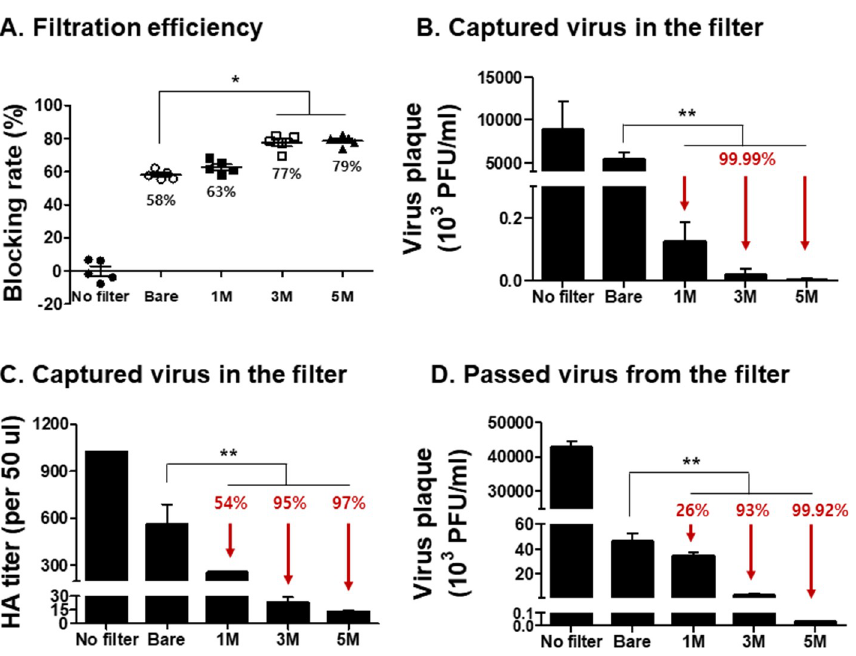
Fig 3. Virus blocking rate, virus plaques, and HA titers from captured or passed viruses using a high amount of aerosolized viruses. Surgical mask filters were coated with 1, 3, and 5M of salt then exposed to a high amount of aerosolized virus (A/H3N2, 8mg/ml, 3.5x10 6 pfu). (A) Virus block efficiency of salt coated filters (n = 5, mean ± SEM, � P < 0.05), (B) virus titer captured in the mask filter (n = 5, mean ± SEM, �� P < 0.01), (C) HA titer of virus captured in the mask filter (n = 5, mean ± SEM, �� P < 0.01), and (D) titer of virus passing through the mask filters (n = 4, mean ± SEM, �� P < 0.01). No filter refers to a virus control group, which does not pass through the mask filters. Bare refers to a control group, where aerosolized viruses pass through uncoated mask